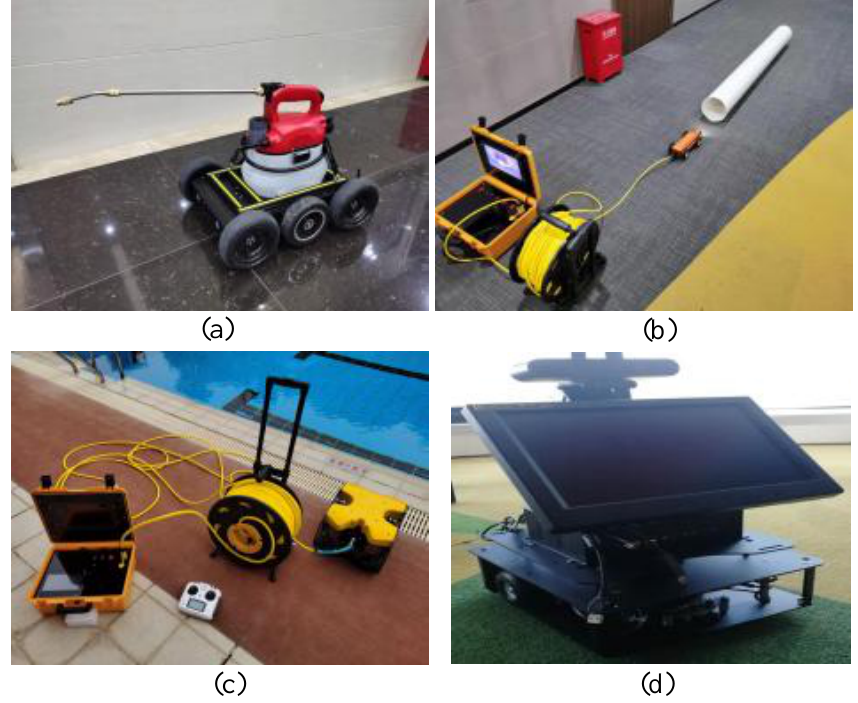
Figure 8. Some robots with different functions: ( a ) Spraying robot; ( b ) Small diameter pipe robot; ( c ) ROV II; ( d ) ROS